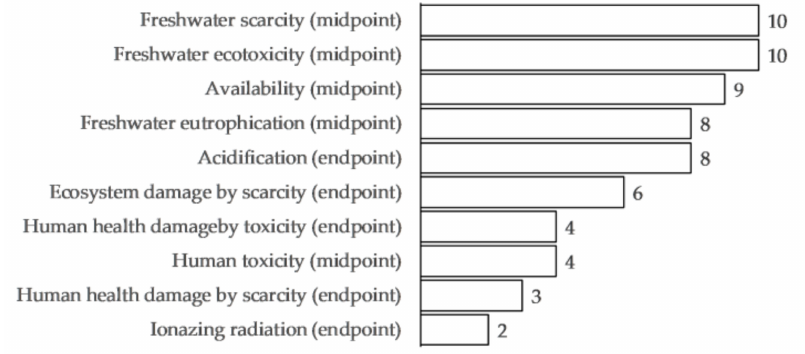
Figure 2. Most used potential environmental impact categories for water footprint studies in Latin America.